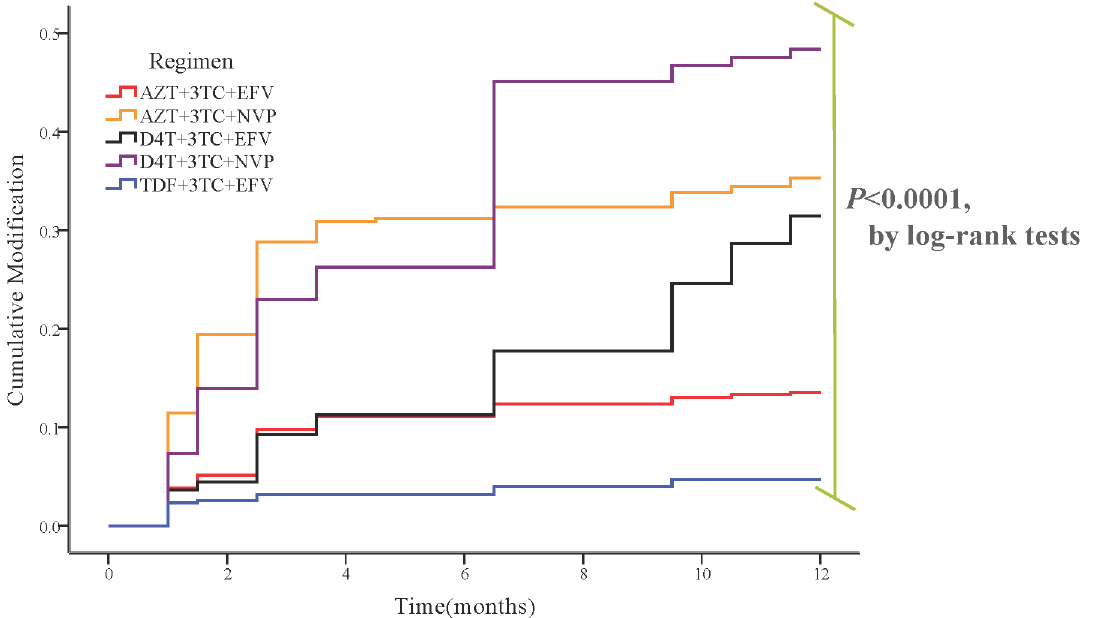
Fig 4. The Kaplan-Meier curve analysis for the first 12 months cART modification